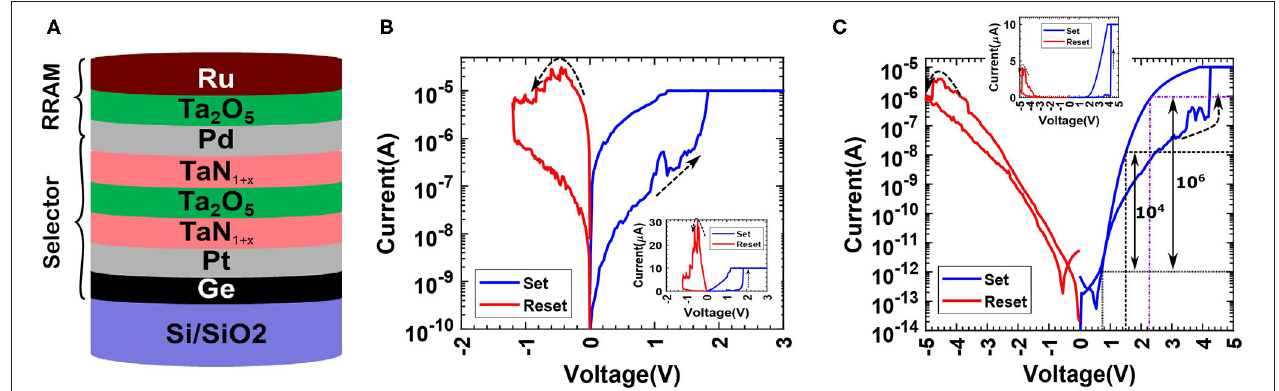
FIGURE 4 | Vertically integrated 1S1R cell. (A) Schematic of the 1S1R cell. (B) Typical I–V characteristics of the Pd/Ta 2 O 5 /Ru based memristor device. (C) Typical I–V characteristics of the 1S1R cell with highly non-linear ON state. The inset shows a linear plot of the same I–V.